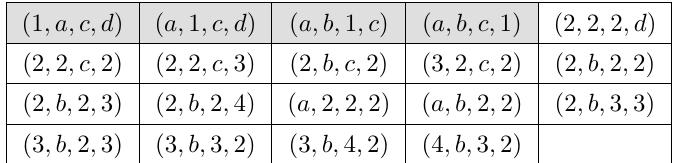
Table 22 . Infinite sequences of type XVIII singularities. The gray entries have at least one of a, b, c, d = 1 , which gives trivial 1-form symmetry. This table is adapted from